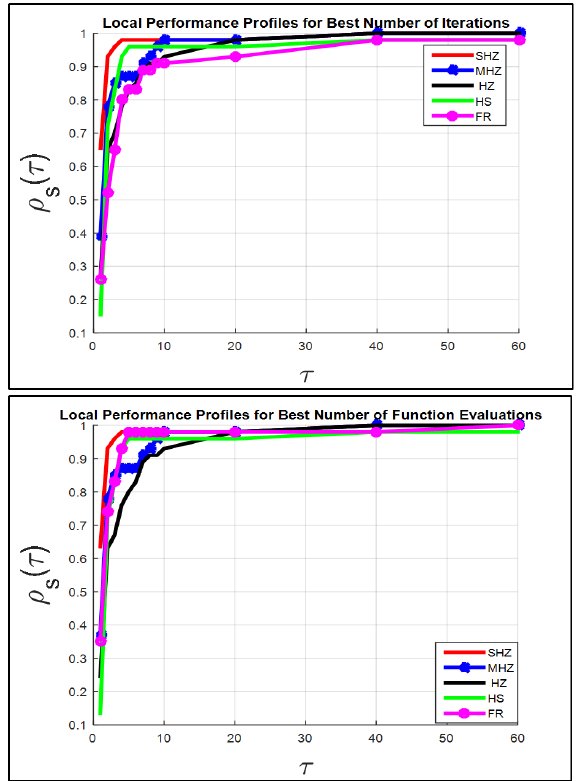
Figure 2. Plotting the results of the terms itr.be and FEs.be for 5